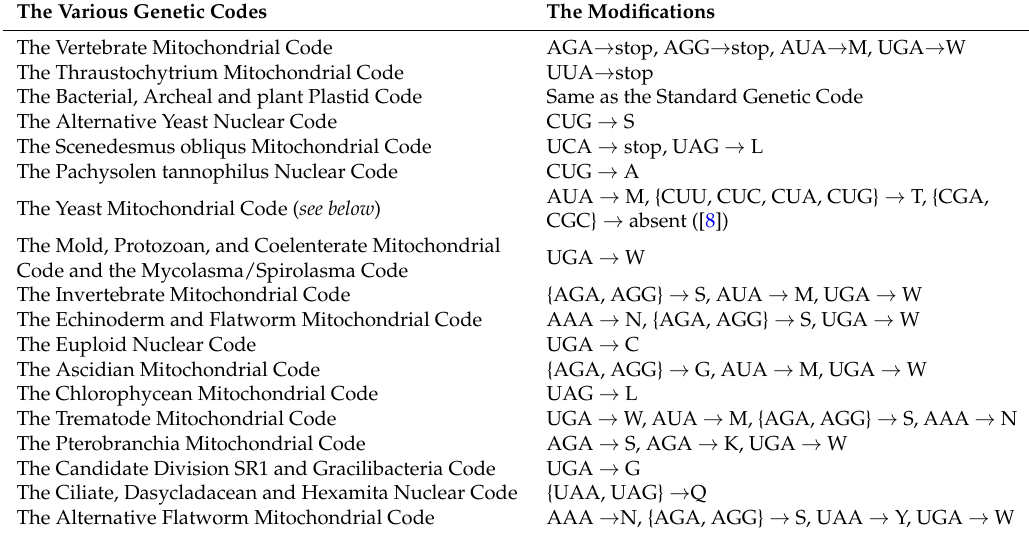
Table 2. The modifications, in the genetic codes, with respect to the standard genetic